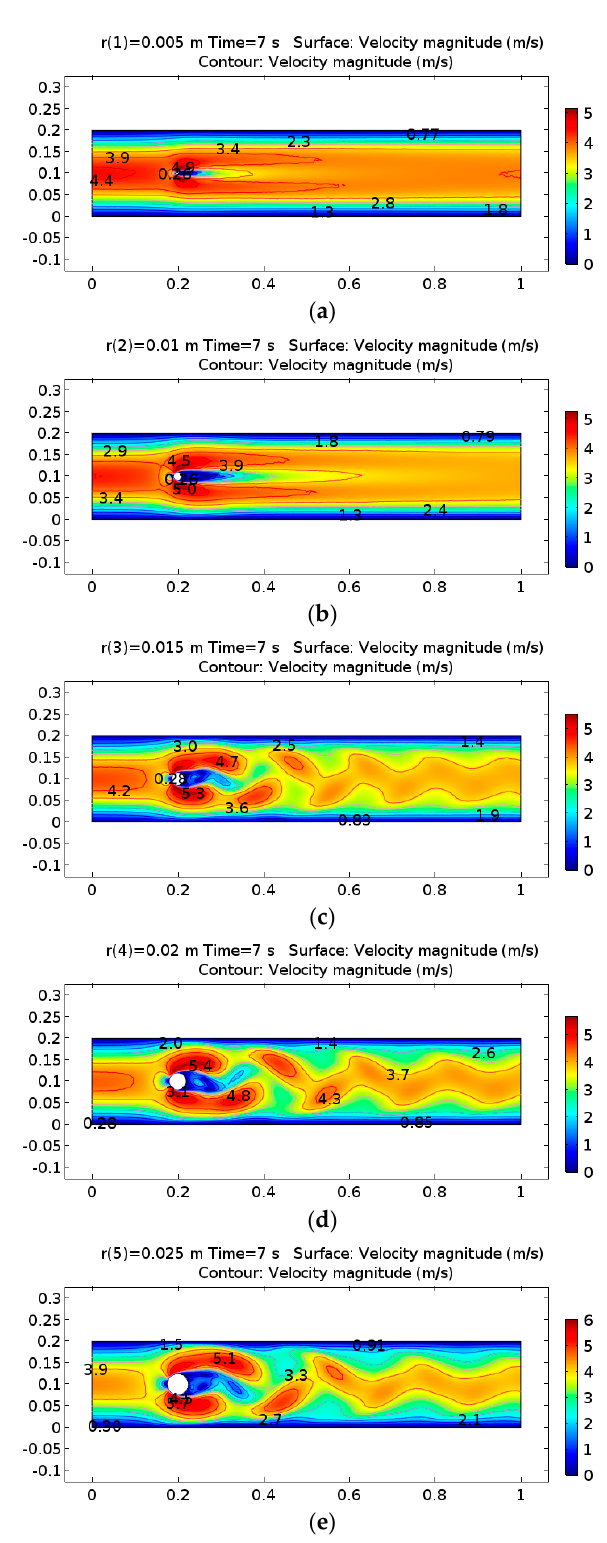
Figure 4. Development of fluid velocity contour demonstrating von Karman vortex streets behind a bluff body. ( a ) Diameter = 1 cm; ( b ) Diameter = 2 cm; ( c ) Diameter = 3 cm; ( d ) Diameter = 4 cm; ( e ) Diameter = 5 cm.